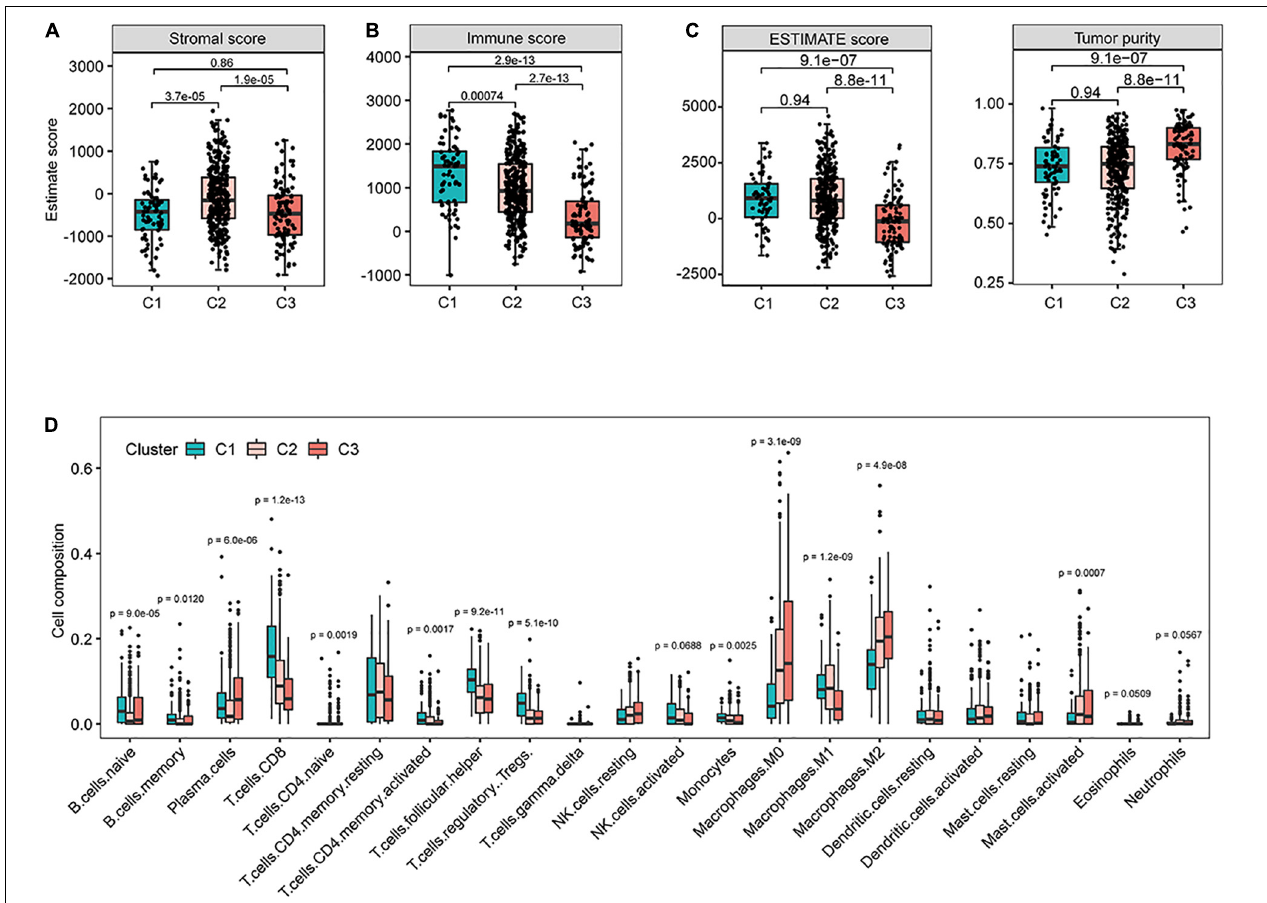
FIGURE 5 | Identification of immune characteristics for different subtypes in The Cancer Genome Atlas (TCGA) cohort. The distribution of stromal score (A) , immune score (B) , ESTIMATE score, and tumor purity (C) for patients in different subtypes. (D) The infiltrating levels of 22 immune cell types in different subtypes in The Cancer Genome Atlas (TCGA)